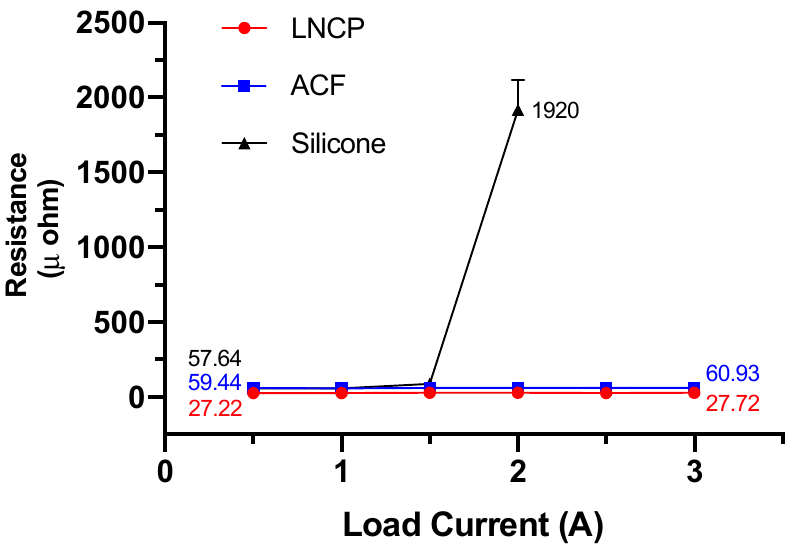
Figure 13. The relationship between applied current and the electrical resistivity of the joints with Cu substrate.